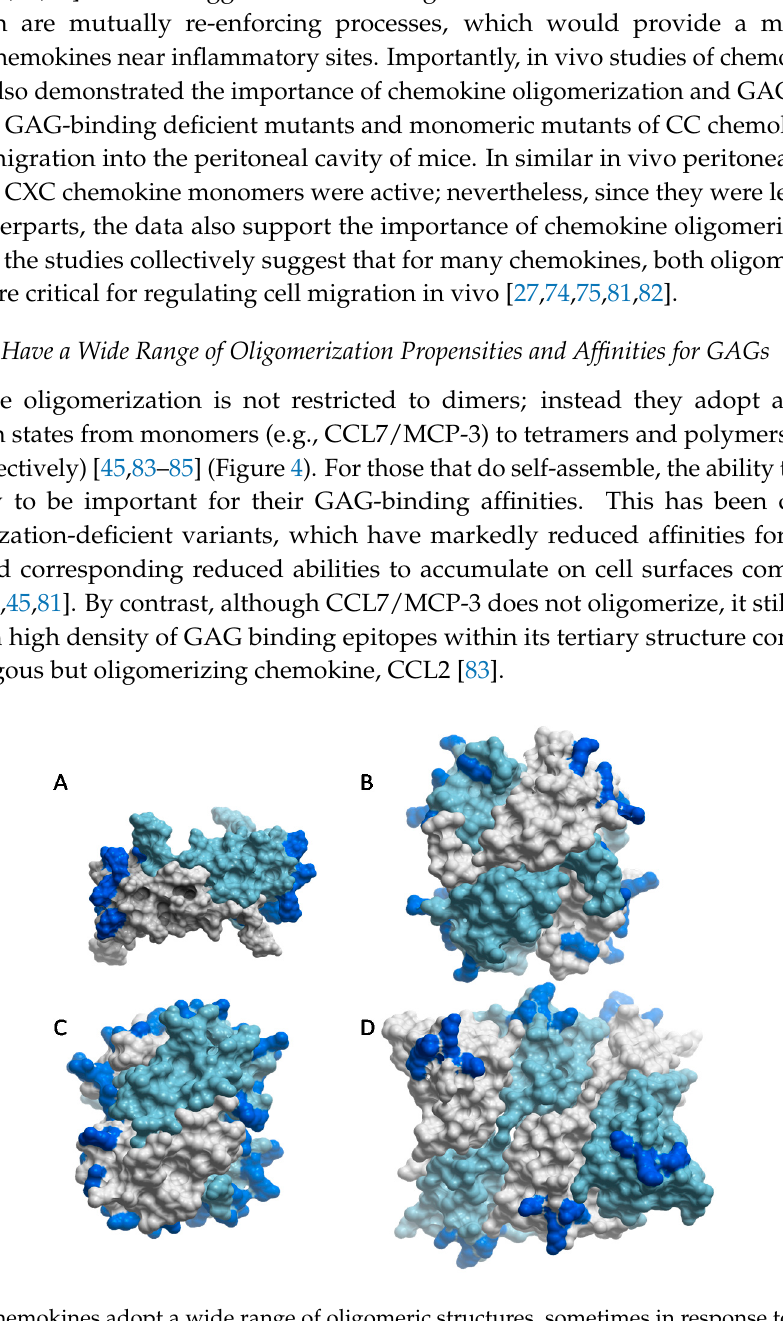
Figure 4. Chemokines adopt a wide range of oligomeric structures, sometimes in response to different GAGs. Structures are shown with the different chemokine subunits color-coded in sky blue and gray, and the main GAG binding residues highlighted in dark blue. ( A ) The CCL2 dimer, which binds to HS (PDB ID 1DOM [68]); residues highlighted include R18, K19, R24, K49. K58, H66 [55]. ( B ) The CCL2 tetramer, which binds to heparin (PDB ID 1DOL [86]); residues highlighted include R18, K19, R24, K49. K58, H66 [55]. ( C ) The CXCL4 tetramer, which binds to heparin (PDB ID 1RHP [85]); residues highlighted include R20, R22, K46, R49, K61, K62, K65, K66 [87]. ( D ) The CCL5 polymer (PDB ID 5DNF [84]); residues highlighted include K55, K56 and R59 [58,88].